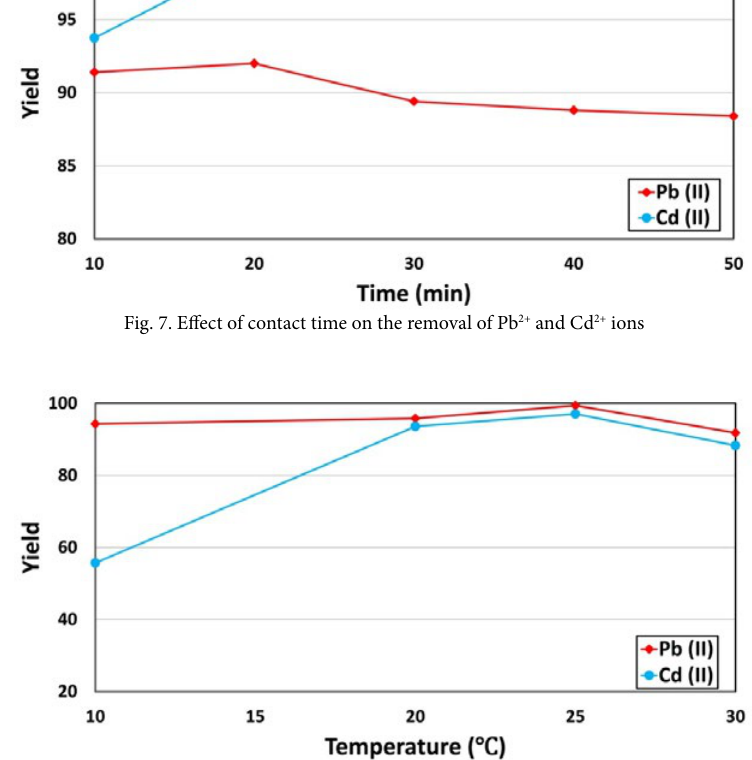
Fig. 8. Effect of temperature on the removal of Pb 2+ and Cd 2+ ions